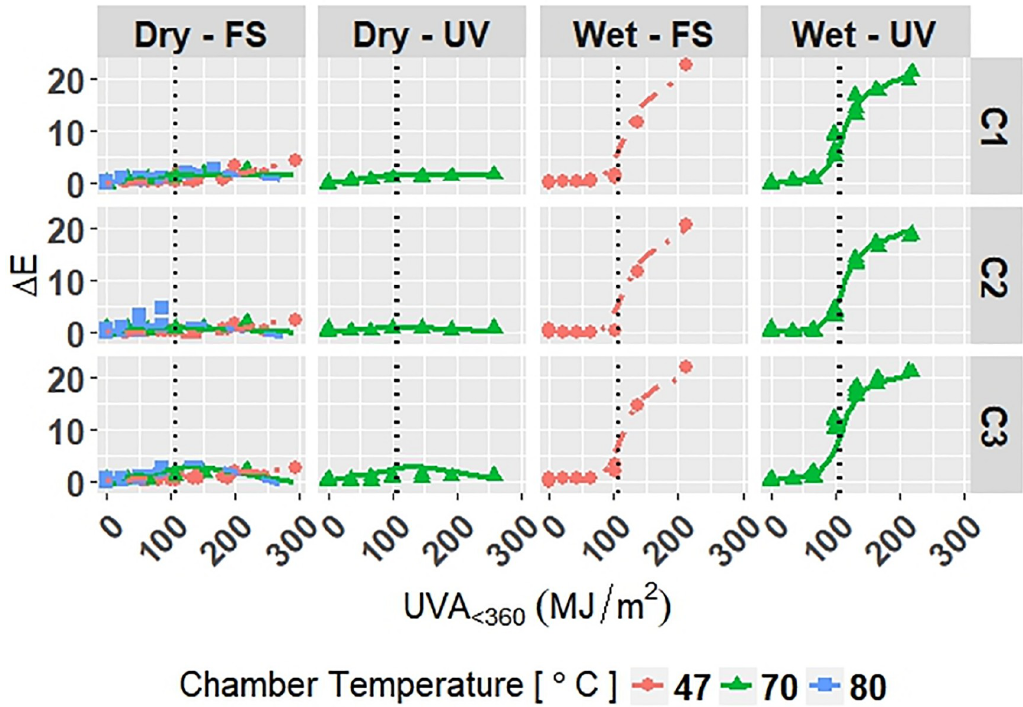
Fig 6. The change in Δ E of clear grades of PET under accelerated exposures with the model curves superimposed on the data. Points represent the measured data and solid and dashed lines represent the models. Vertical, dotted lines represent the location of natural spline